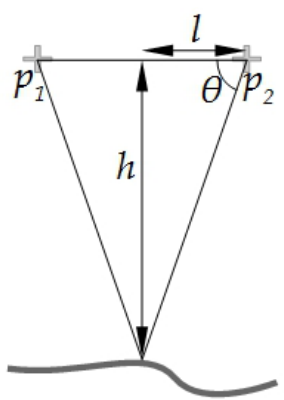
Figure 12. Schematic of the relationship between height ( h ), base- line length ( l ) and the interior angle ( θ ) that may be affected by a bias ( rθ ) for a terrain point position resected from images centred at p1 and p2, when the mean bias ( rθ ) is small (e.g. 0.014 ◦ in this